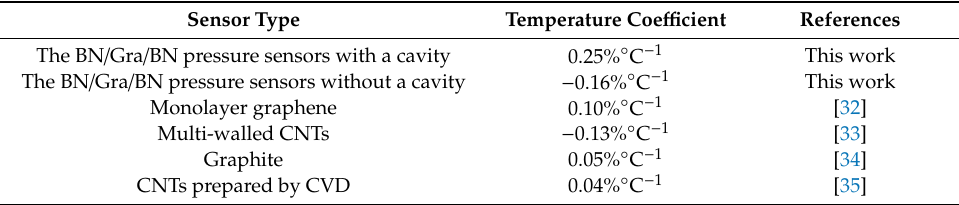
Figure 5. Experimental characterizations of the BN / graphene / BN pressure sensors: ( a ) test structure diagram of the pressure sensor with a cavity; ( b ) the fractional change in the electrical resistivity variation of the BN / graphene / BN pressure sensor with a microcavity over the range 30–150 ◦ C; ( c ) the fitting curve of the BN / graphene / BN pressure sensor with a microcavity over the range 30–150 ◦ C; ( d ) test structure diagram of the pressure sensor without a cavity; ( e ) the fractional change in the electrical resistivity variation of the BN / graphene / BN pressure sensor without a microcavity over the range 30–150 ◦ C; ( f ) the fitting curve of the BN / graphene / BN pressure sensor without a microcavity over the range 30–150 ◦ C. Table 1. Some types of temperature sensors and their